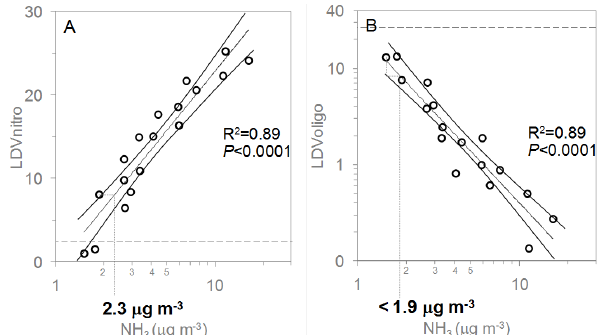
Fig. 3. Critical loads of N deposition considering the nitrophytic (A) and oligotrophic (B) functional groups. N deposition was cal- culated from LADD model and correlated to changes of LDVnitro (nitrophytic) and LDVoligo (oligotrophic). Considering the confi- dence intervals of the regression line (95%) and the last point with a LDV still within the control values (dotted lines) the critical load was established. Because the observed values of LDVoligo are be- low the control value, a critical load lower than 26kgha − 1 yr − 1 should be considered.